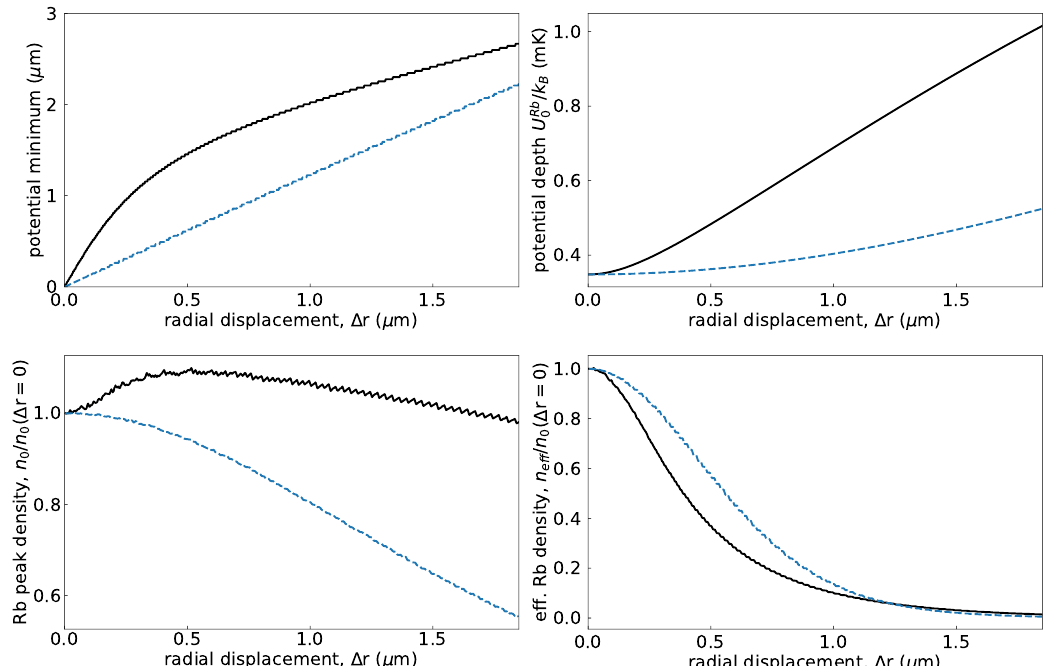
Figure 5. Numerically calculated locations of the minimum of the bichromatic potential for Rb atoms ( top left ), the corresponding trap depths U Rb ( top right ), peak density normalized to the value obtained in the case of full VIS/NIR ODT 0 alignment n 0 / n 0 ( ∆ r = 0 ) ( bottom left ), and the effective normalized Rb density probed by the Ba ion n ef f / n 0 ( ∆ r = 0 ) as a function of radial displacement ∆ r between the VIS and NIR ODTs ( bottom right ). Results for OTDs with matched beam = 2 w NIR = 7.4 µ m) are shown as black solid lines (blue dashed lines). For the data in the waist radii of w 0 = 3.7 µ m ( w VIS 0 0 lower panels a 10-point gliding average has been applied.